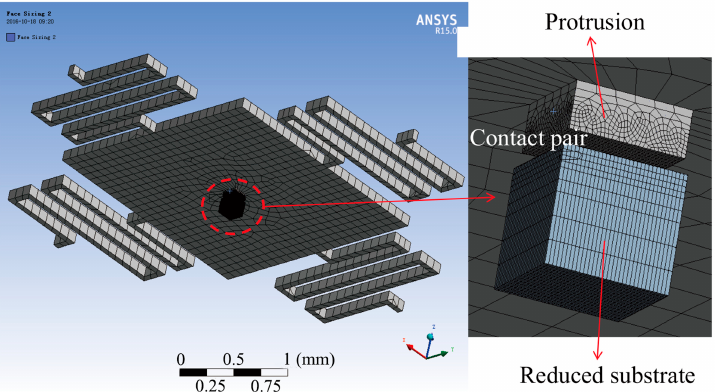
Figure 2. Finite element model of the micro-switch with the contact pair of the protrusion and reduced substrate. Table 2. Main material properties of the device structure.